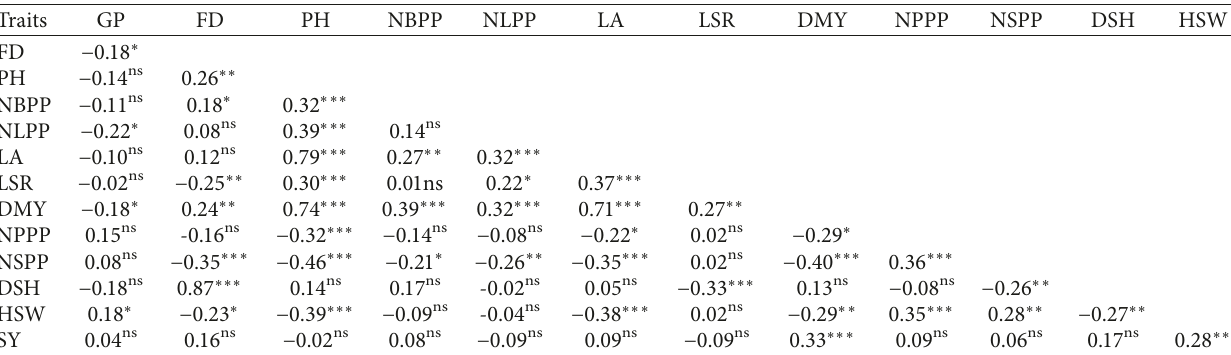
Table 13: Pearson’s correlation coefficient between agronomic traits of Lablab purpureus in Tepi, Bechi, and Kite testing sites.